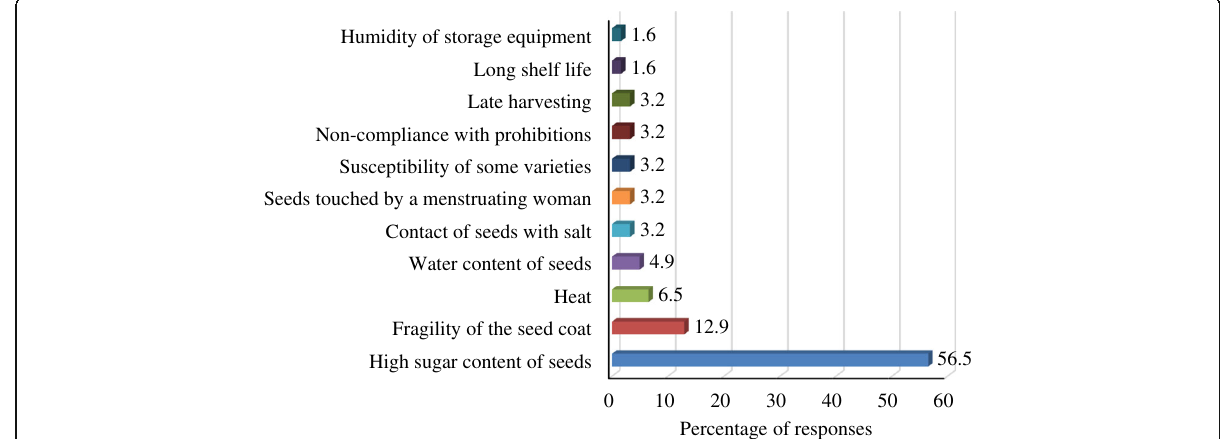
Fig. 3 Famers ’ perceptions of the factors favoring the attacks of stored Kersting ’ s groundnut seeds by